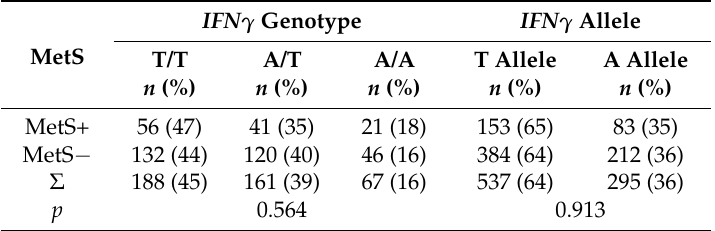
Table 2. Analysis of the distribution of the IFN γ gene rs2430561 polymorphism with regard to